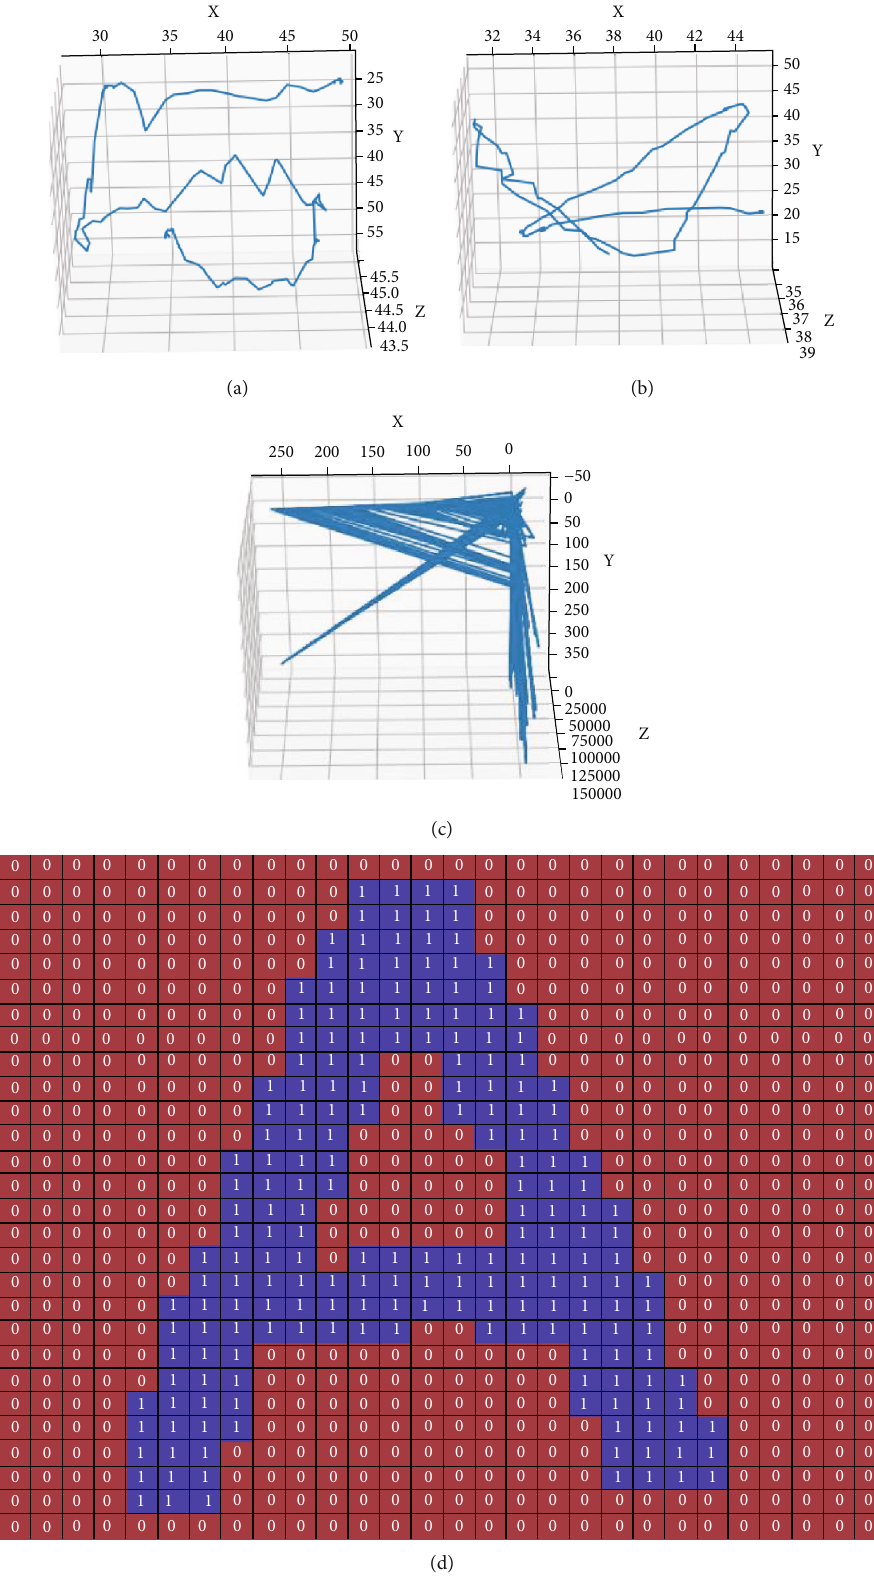
Figure 1: Raw dataset samples. (a) An RTD dataset sample (digit “ 5 ” ). (b) An RTC dataset sample ( “ A ” ). (c) A smart-band dataset sample ( “ A ” ). (d) An Abas dataset sample ( “ A ”